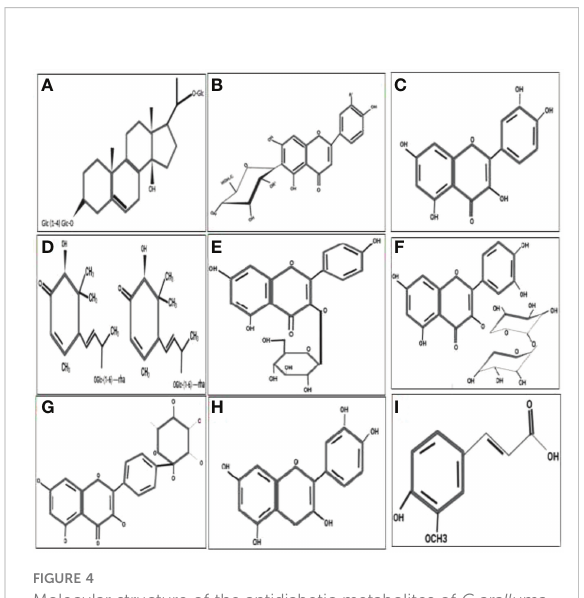
FIGURE 4 Molecular structure of the antidiabetic metabolites of C aralluma tuberculata . (A) Pregnane glycosides. (B) Flavone glycosides. (C) Quercetin. (D) Megastigmane glycosides. (E) Kaempferol 3- b - D - glucopyranoside. (F) Rutin. (G) Kaempferol-4 ′ - O -alpha- L - rhamnopyranoside. (H) Catechin. (I) Ferulic